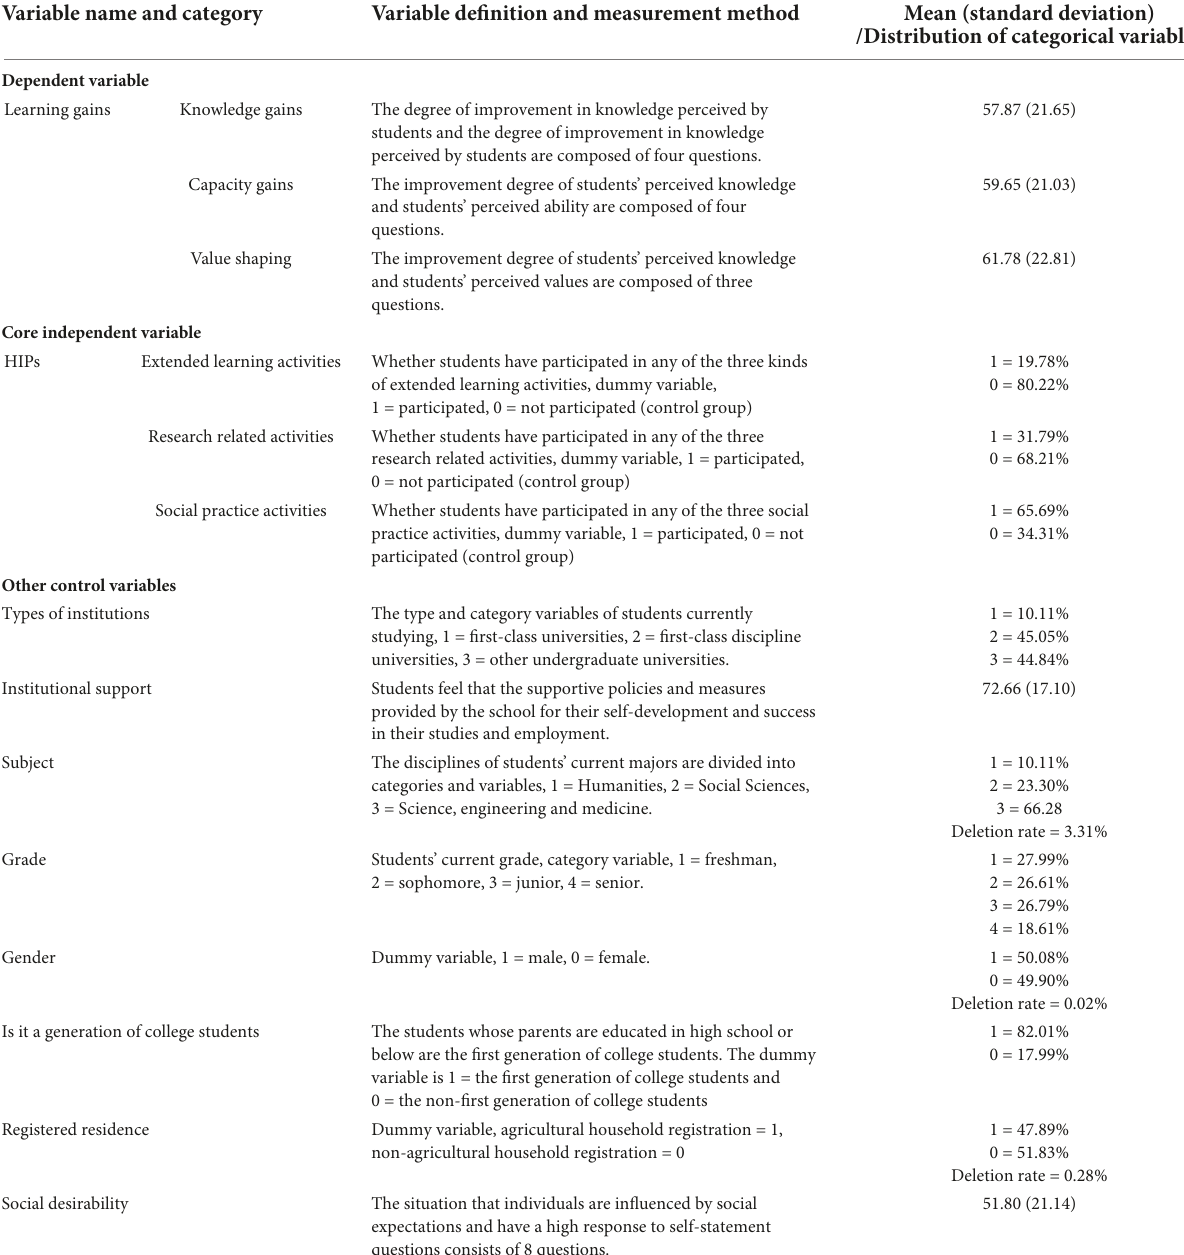
TABLE 2 Constituent dimensions and descriptive statistics of